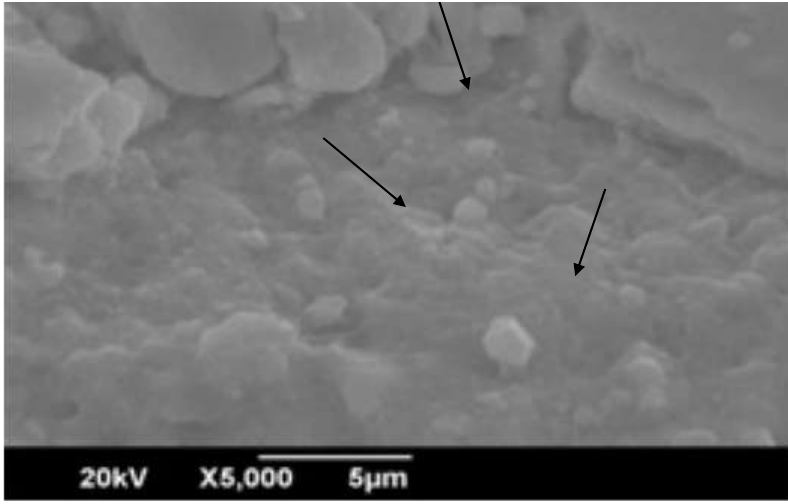
Fig. 4. SEM micrograph showing well dispersed spherical Silver Nanoparticles Fig 4 SEM micrograph showing well dispersed spherical silver Nanoparticles Table 1 The particle size of Bio – Ag NP calculated by Debye – Scherrer formula Table 1 The particle size of Bio – Ag NP calculated by Debye – Scherrer 2Ɵ of intense peak